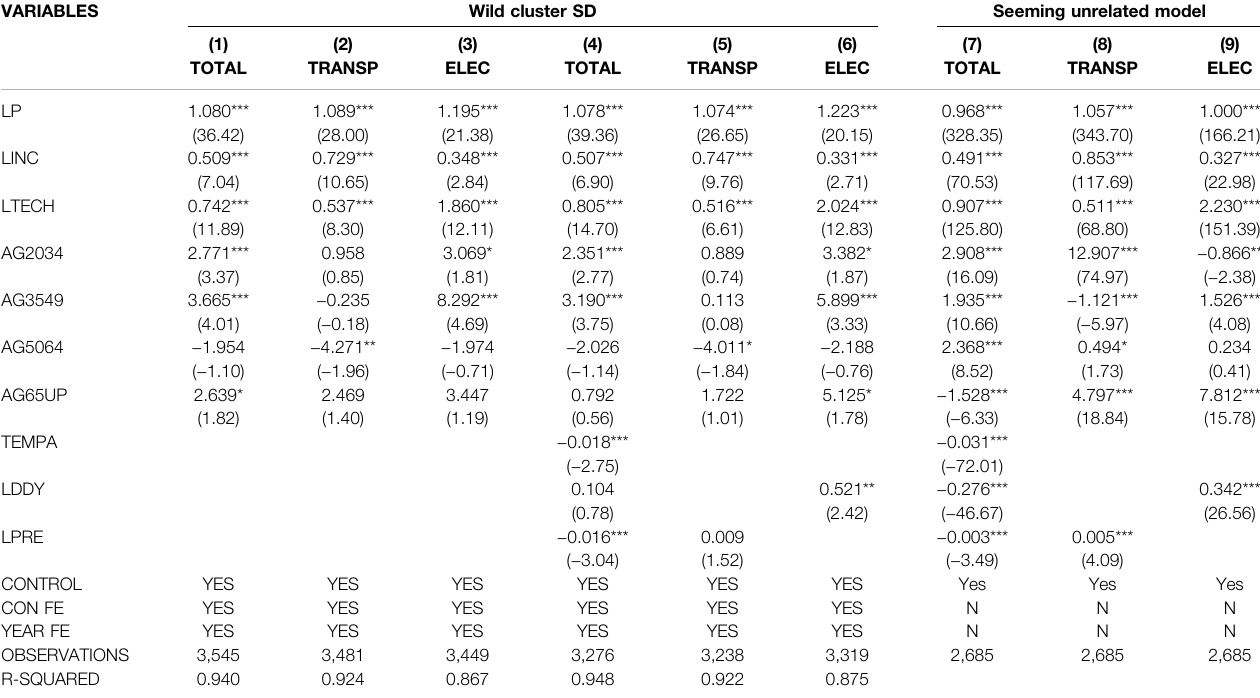
TABLE 4 | Results of climate-extended STIRPAT with wild cluster bootstrap and SURE method